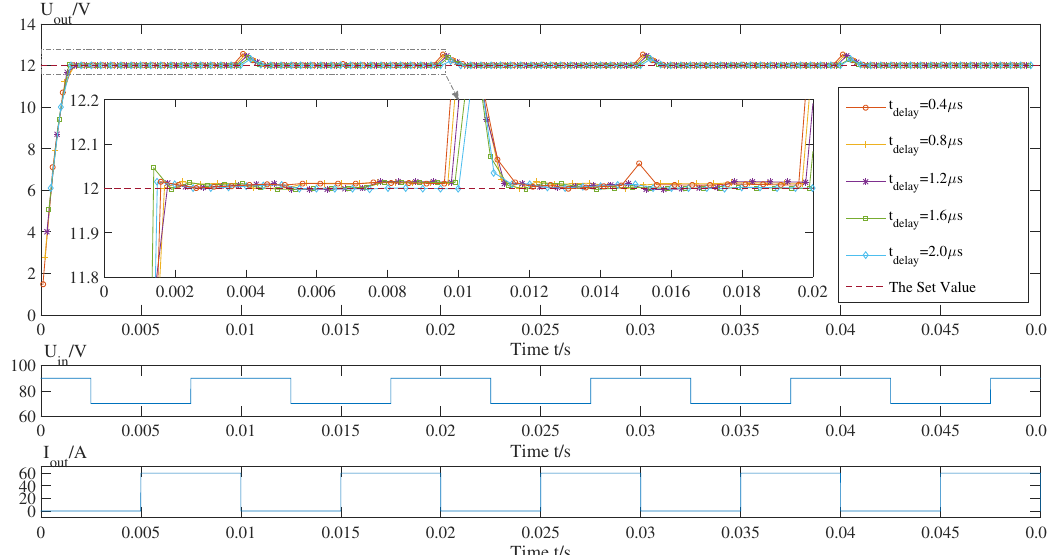
Figure 5. The output voltages of the Buck circuit in the proposed PD-COT mode with different time delays. In order to clarify the advantages of the proposed scheme, a comparison of the performances of the same Buck circuit with COT and PD-COT methods is made. The results are displayed in Figure 6. From Figure 6, it can be seen that, compared with the dark blue line (classical COT), the orange line (proposed PD-COT) performs well. The advantages are stated in the preceding paragraph. Although the static difference should be increased by the introduction of the PD module, the control scheme keeps it at an extremely low level with the help of the dynamic reference voltage. Furthermore, with the game mechanism, the system maintains its ability to repress overshoot and recover quickly from sudden changes. Because the structure of the PD module is simple, the cost of the controller is not greatly increased, and the controller has only four core parameters, which can be set and optimized easily.